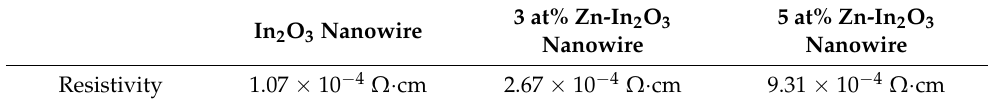
Table 1. Electrical resistivity measurements for single In 2 O 3 , 3 at% Zn-In 2 O 3 , and 5 at% Zn-In 2 O 3 nanowire. 3 at% Zn-In 2 O In 2 O 3 Nanowire